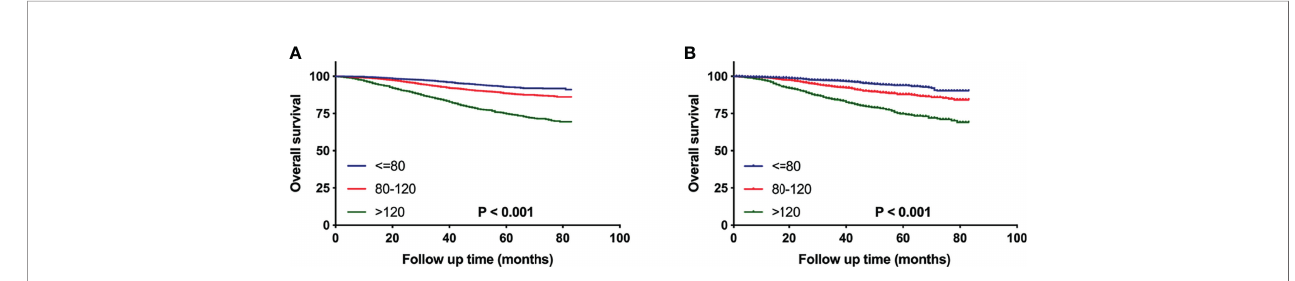
FIGURE 5 | Overall survival of pT1-2N0M0 TNBC patients strati fi ed by nomogram sum-score in the training (A) and validation (B)